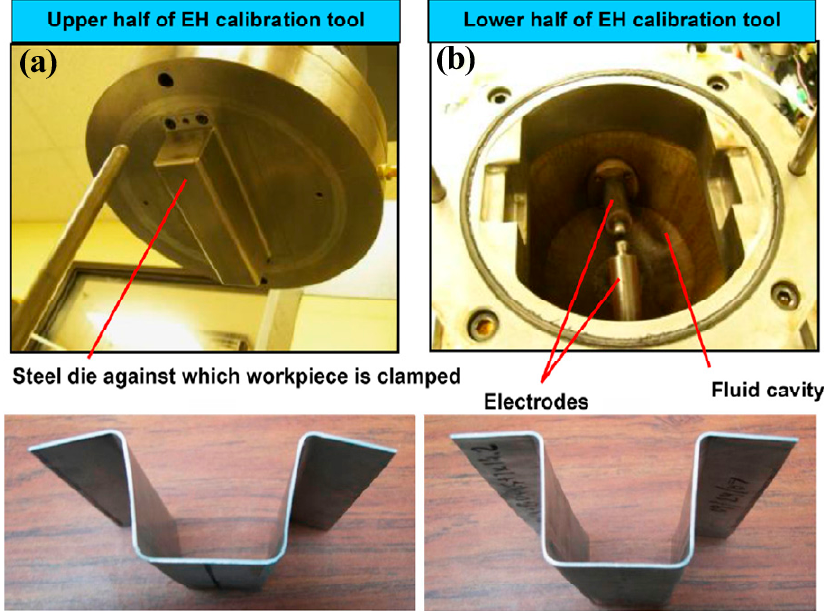
Figure 17. Springback calibration of 6111-T4 aluminum sheet with EHF [115]. Reprinted with permission from Ref. [115]. Copyright 2014, J. Mater. Process. Tech. ( a ) Before calibration and ( b ) after calibration.